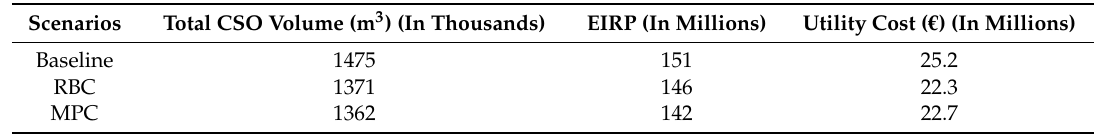
Table 2. Total combined sewer overflow (CSO) volume, environmental impact risk points (EIRP), and total utility cost for the three scenarios.